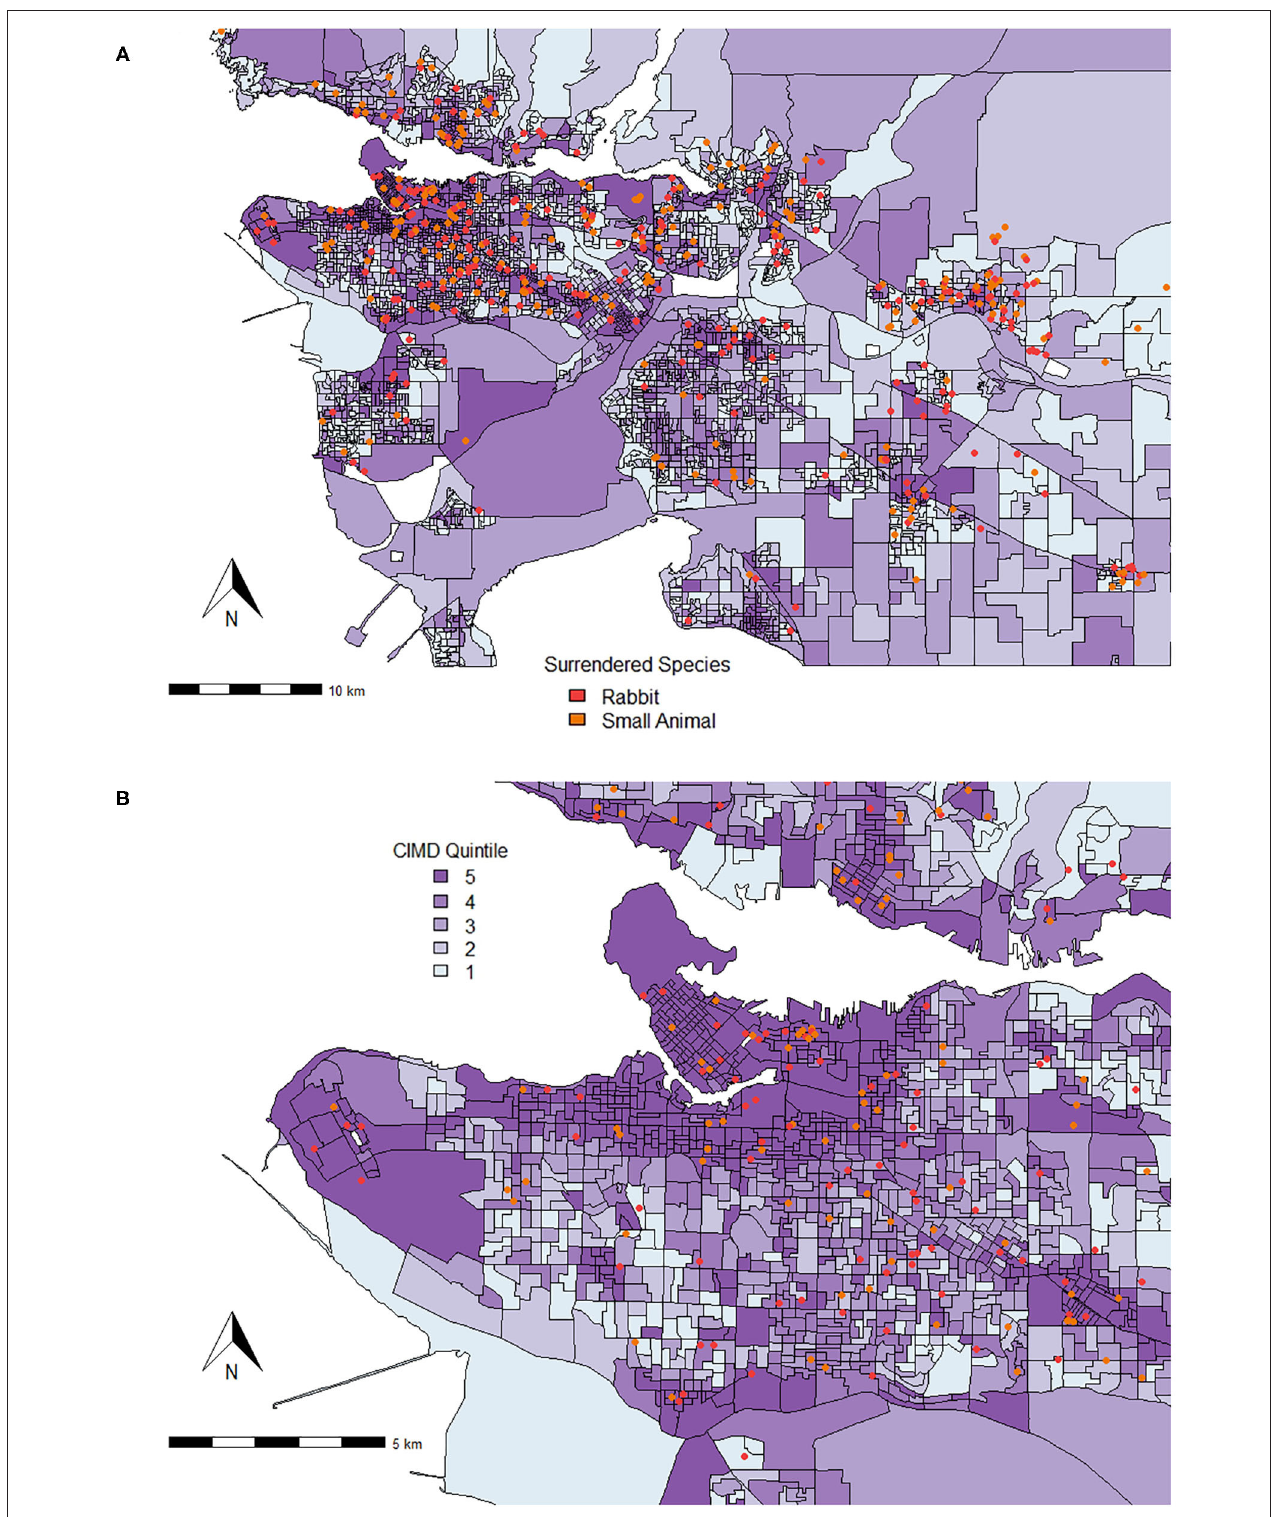
FIGURE 4 | Locations where small animals and rabbits were surrendered from in (A) Metro Vancouver and (B) the City of Vancouver (September 1, 2016 to August 31, 2020) plotted on top of quintiles for Residential Instability (1 = least instable, 5 = most instablr). The Residential Instability factor of the CIMD includes indicators such as the proportion of apartment dwellings; the proportion of persons living alone; the proportion of rented dwellings; and the proportion of population that has moved in the last 5 years. While each point shows the dissemination area of origin, it does not represent the true address.